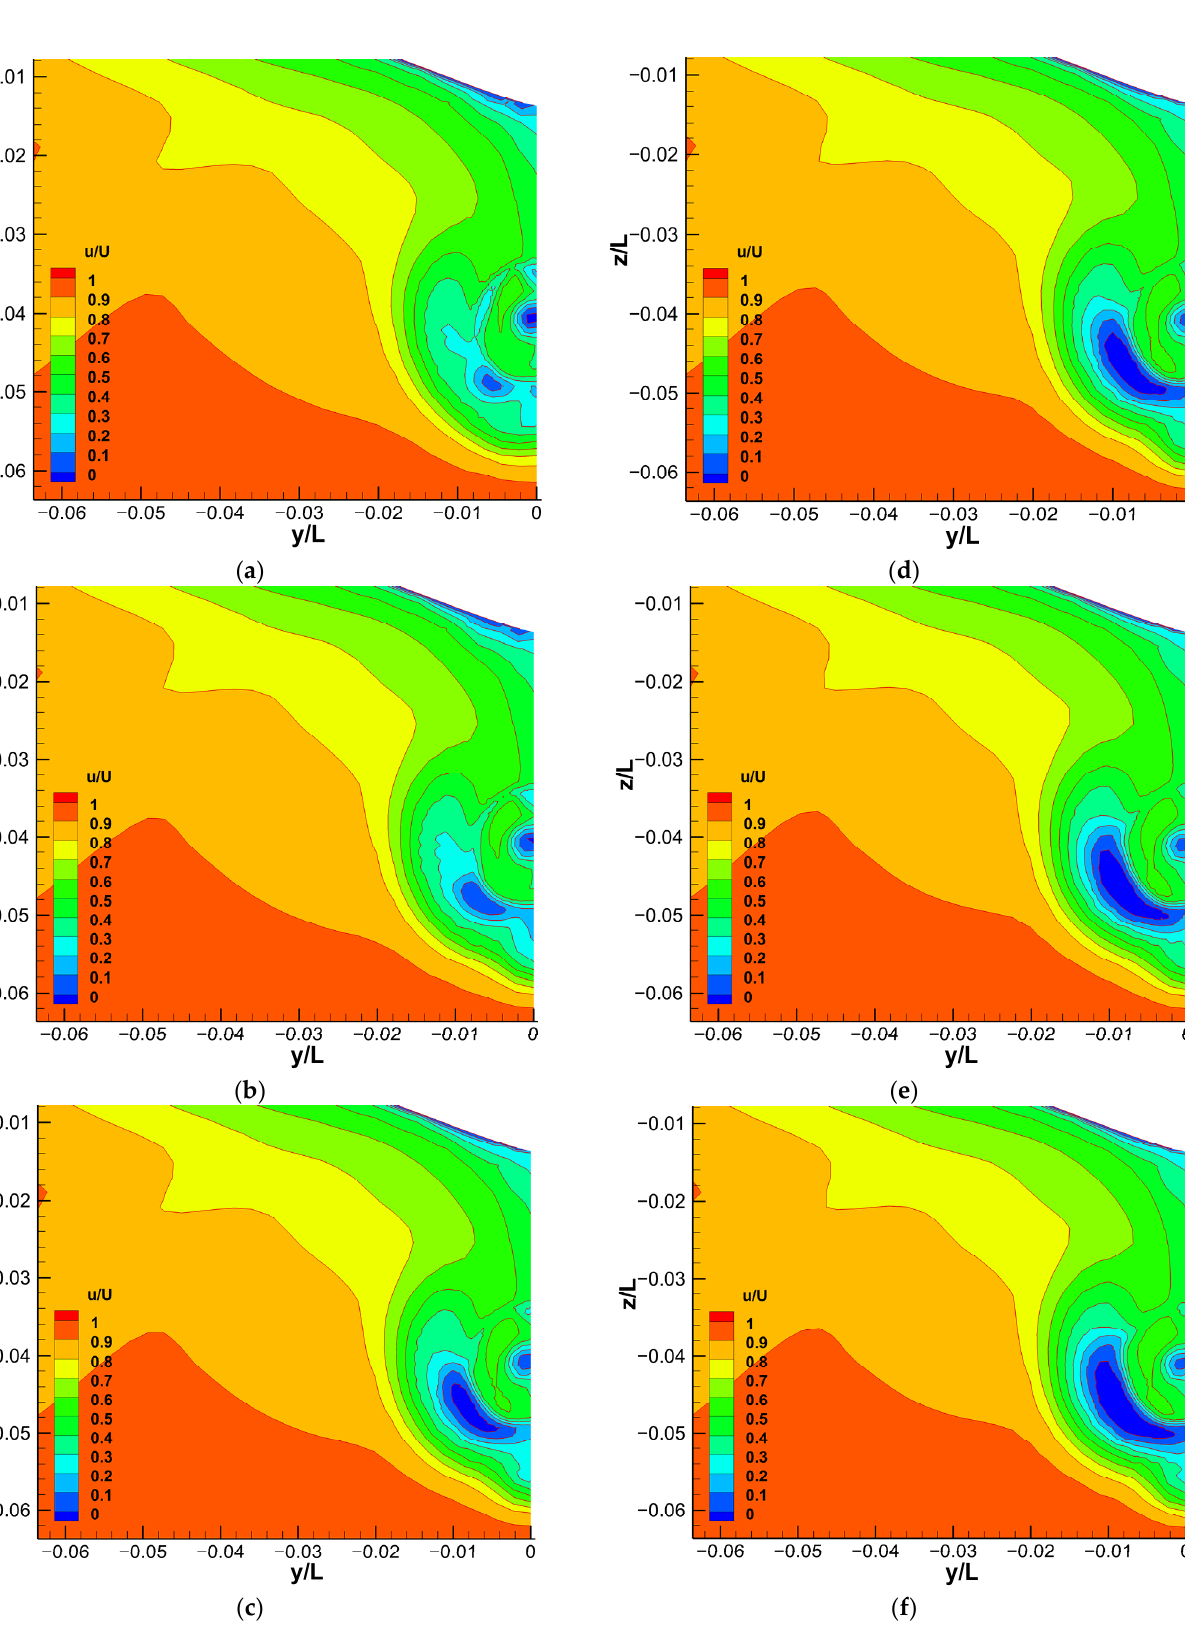
Figure 14. Nominal wake axial velocity profile for different ducts: ( a ) 7 ° ; ( b ) 10 ° ; ( c ) 15 ° ; ( d ) 18 ° ; ( e ) 20 ° ; and ( f ) 23 ° .